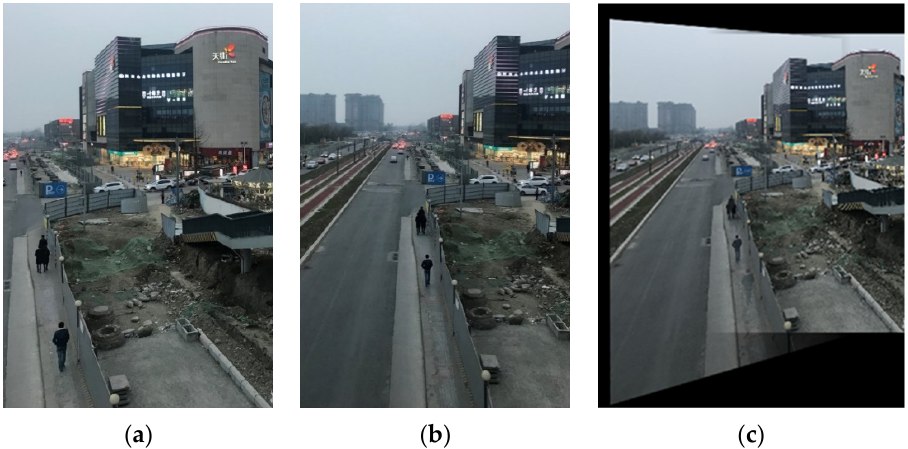
Figure 15. The experimental images of the second scene: ( a ) the reference image; ( b ) the image to be registered; ( c ) the stitched image. Table 3. The registration result comparison of the second scene. Methods